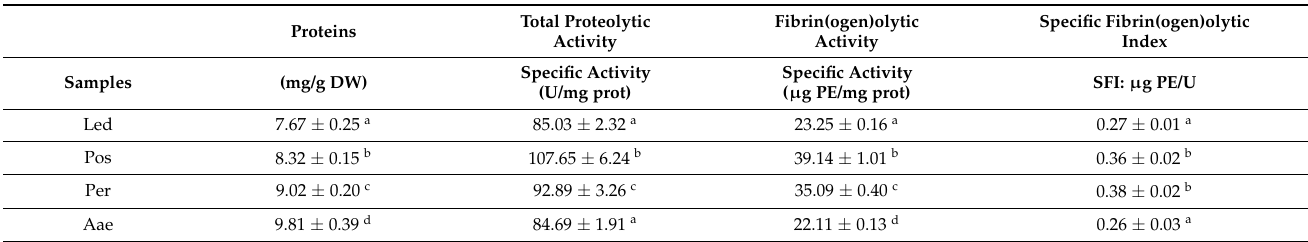
Table 1. Protein content, total proteolytic and fibrin(ogen)olytic activity of crude extracts from the fruiting bodies.